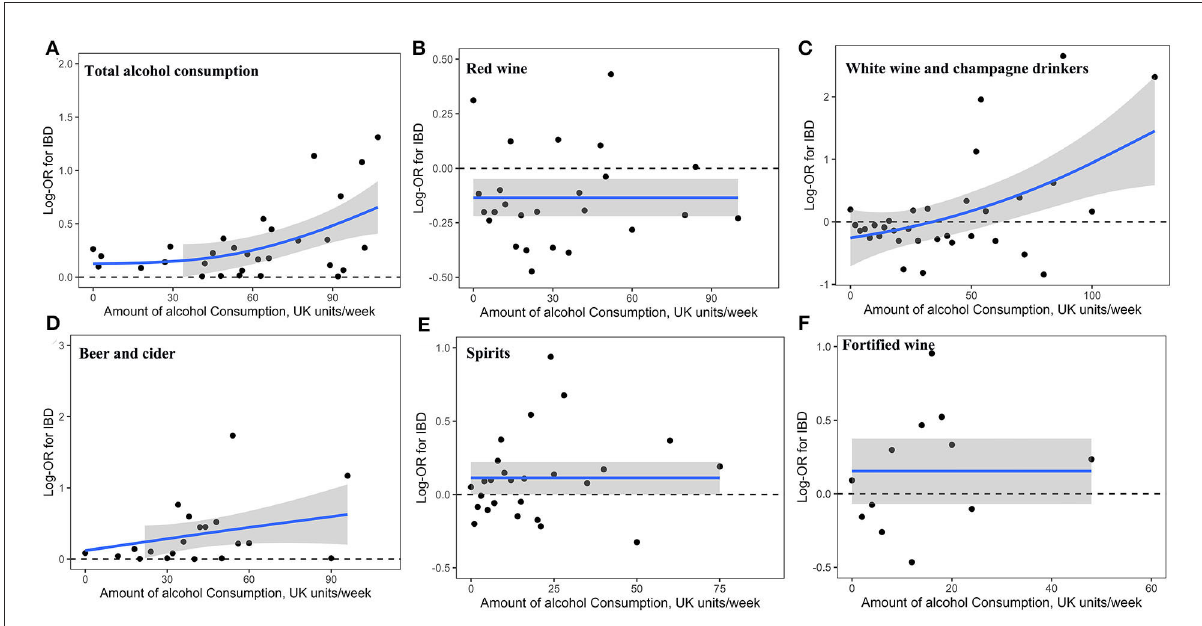
FIGURE1 Association of alcohol consumption with risk of IBD. Linear and non-linear associations of the amount of total alcohol consumption (A) and that of alcoholic beverages ( B , red wine; C white wine and champagne; D , beer and cider; E , spirits; F , fortified wine) with risk of